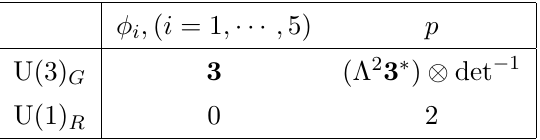
((cid:3) 2 S (cid:3) ) (cid:10)O (1)